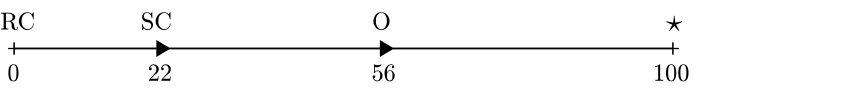
Figure 14. “Utopian operational path” chart. RC—regulatory control; SC—supervisory control; O—optimization; (cid:63) —utopian